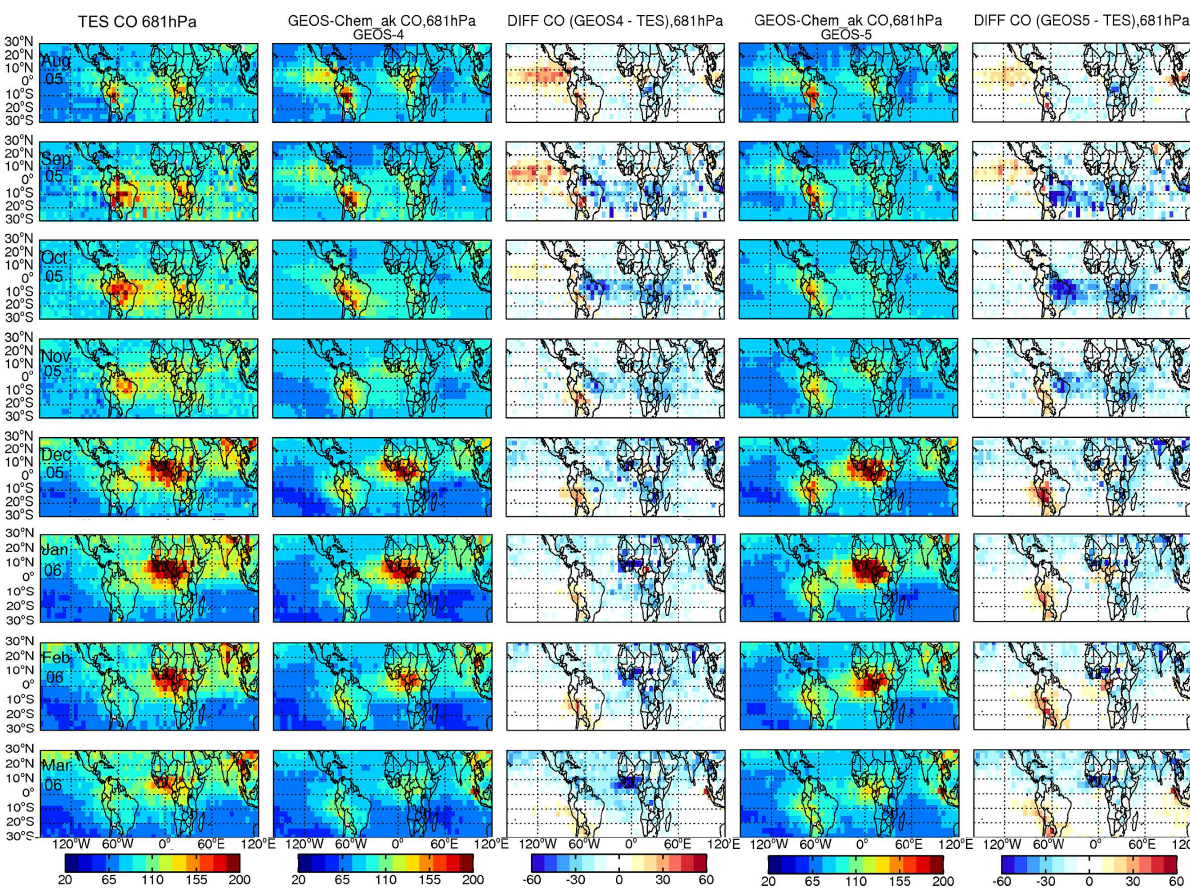
Fig. 3. Lower tropospheric CO at 681hPa from August 2005 to March 2006 from TES (left column), the model driven by GEOS-4 with the TES averaging kernel (AK) applied, and the model wAK–TES difference (2nd and 3rd columns), the model driven by GEOS-5 with the TES AK, and the model wAK–TES difference (the 4th and 5th